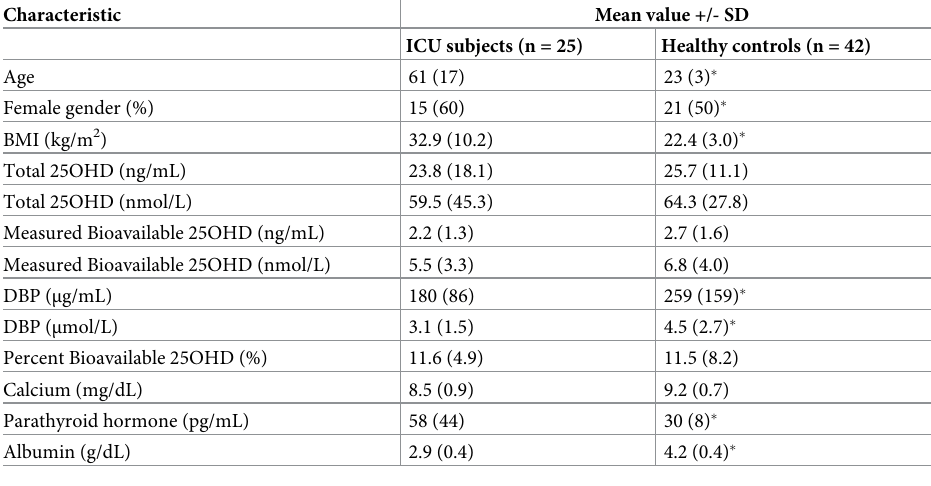
Table 1. Subject